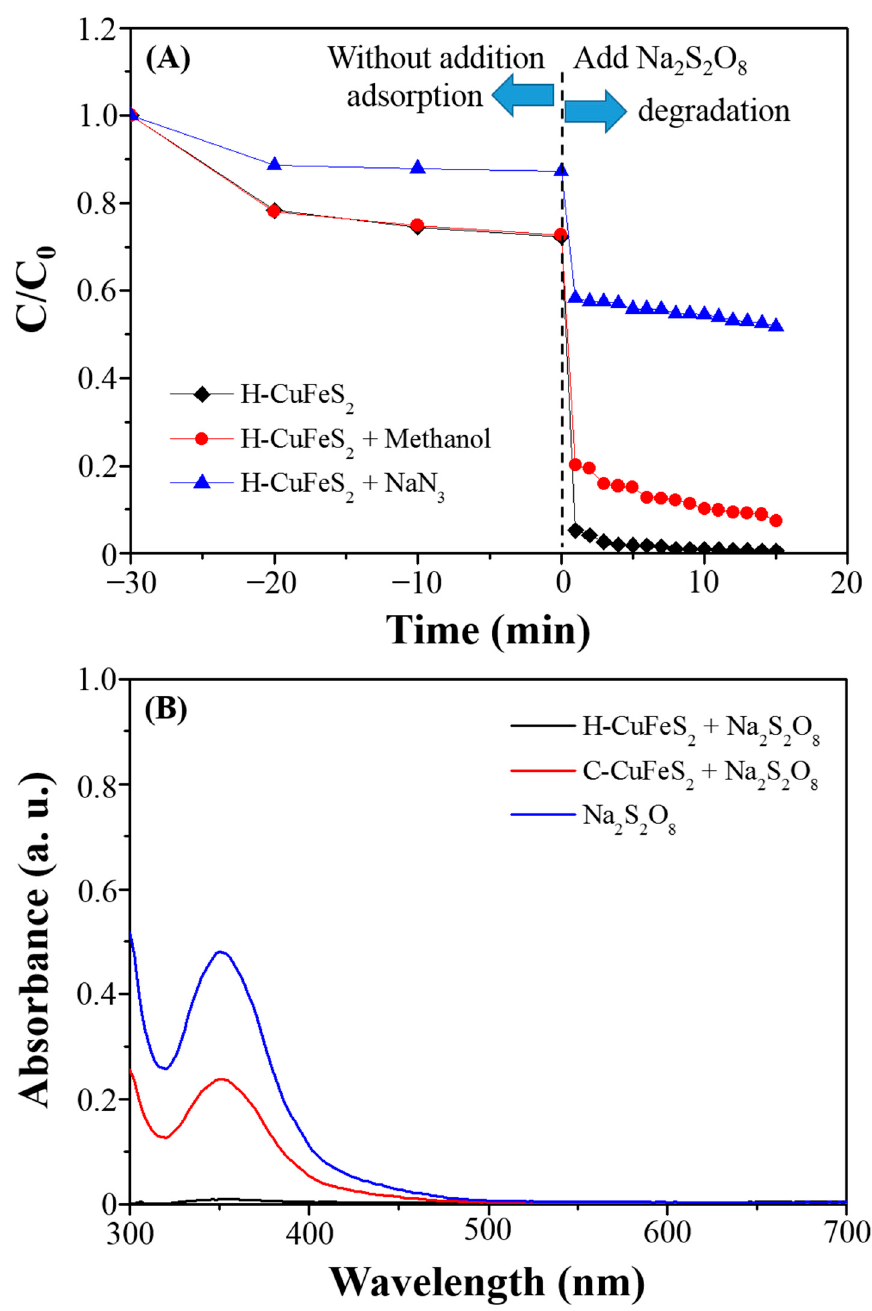
Figure 11. ( A ) Free radical trapping experiment and ( B ) absorbance spectra at different condition.